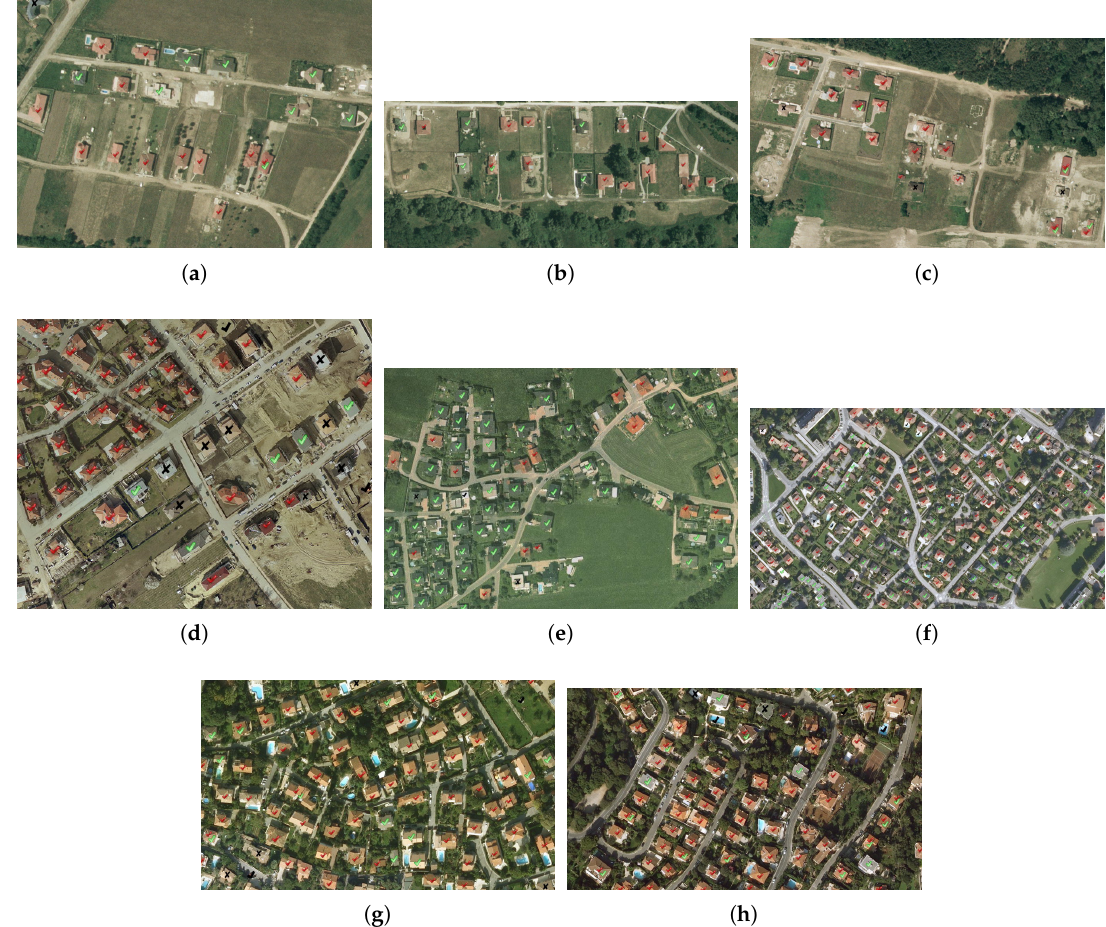
Figure 6. Figure 6a–h show the resultant output of applying DBSV, respectively, on SZADA1,